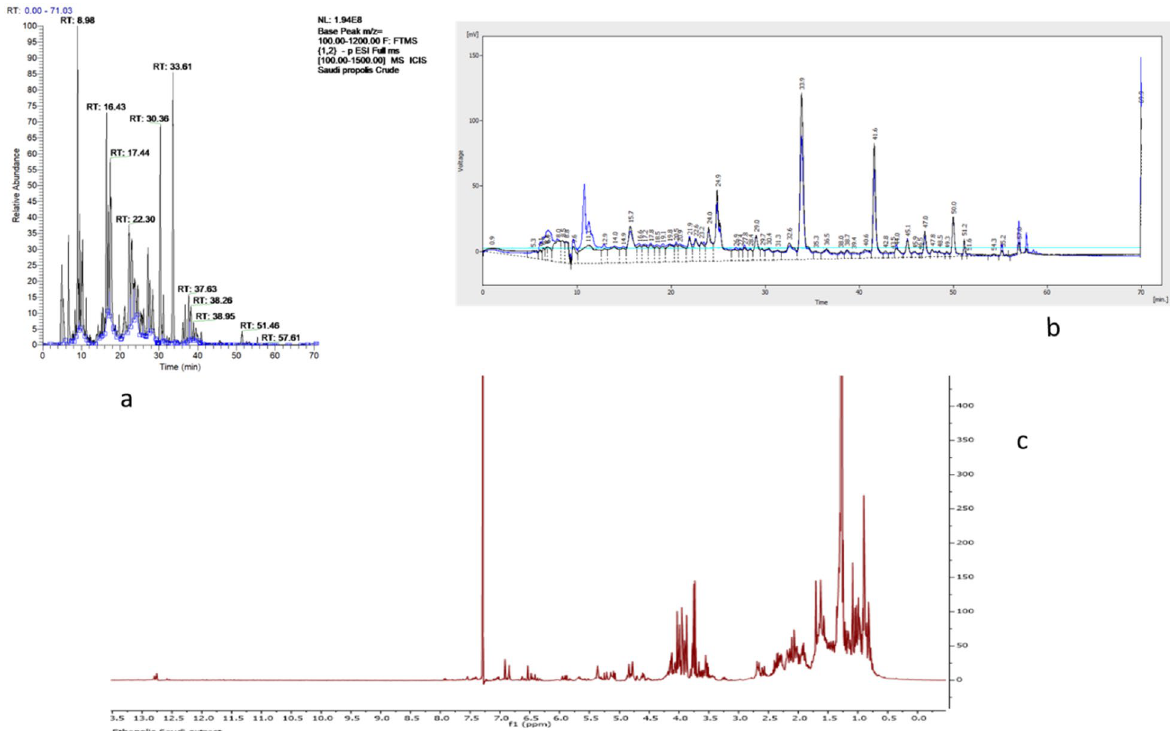
Figure 1. Chemical profile of crude Propolis extract ( a ) LC–MS Chromatogram of ethanol-based crude extract, ( b ) HPLC–ELSD profile of ethanolic crude Propolis extract and ( c ) 1 H NMR spectrum of ethanol-based Saudi propolis extract in CDCl